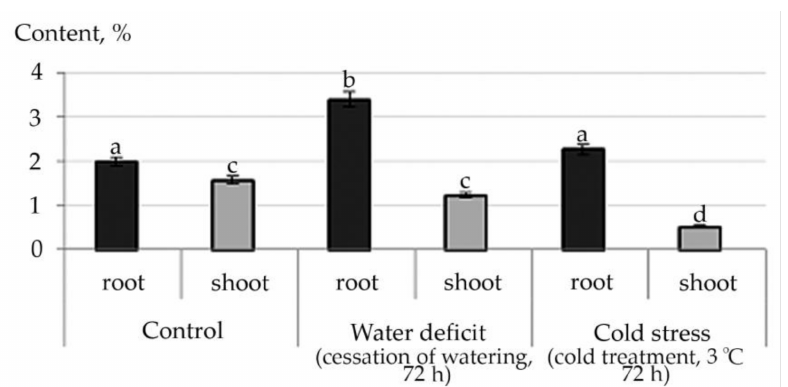
Figure 10. Changes in the content of furan derivatives in root and in shoot using the example of 2 (5H)-Furanone in R. semenowii under stress conditions. Values presented are means ( ± SD). Different letters above the bars represent significant differences at p ≤ 0.05, n = 3 plants in each of 3 replicates for all treatments.